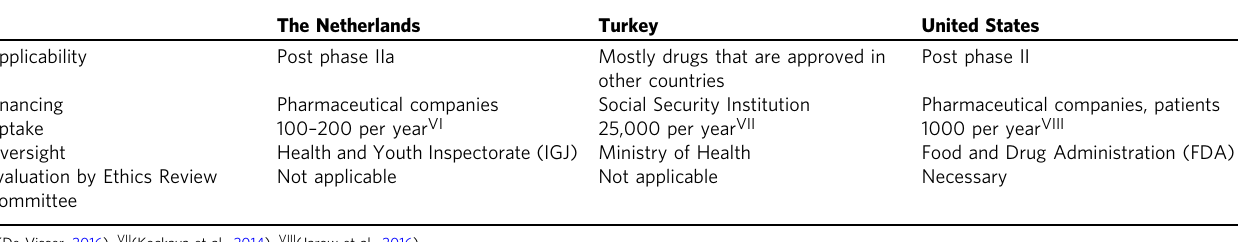
Table 2 Named patient programmes in the Netherlands, Turkey and the United States.